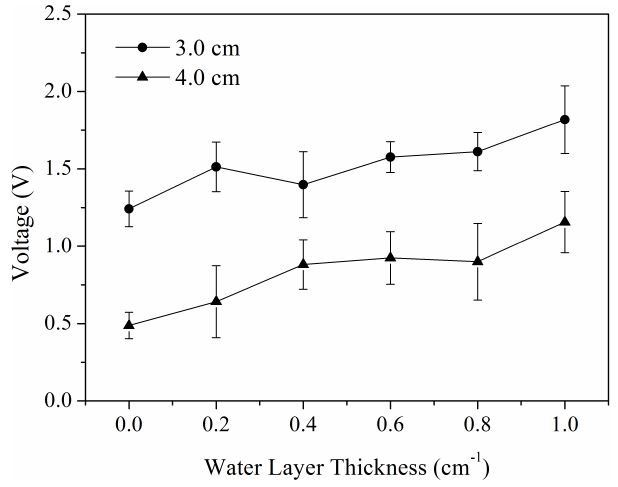
Fig. 8. Voltage with the di®erent water layer